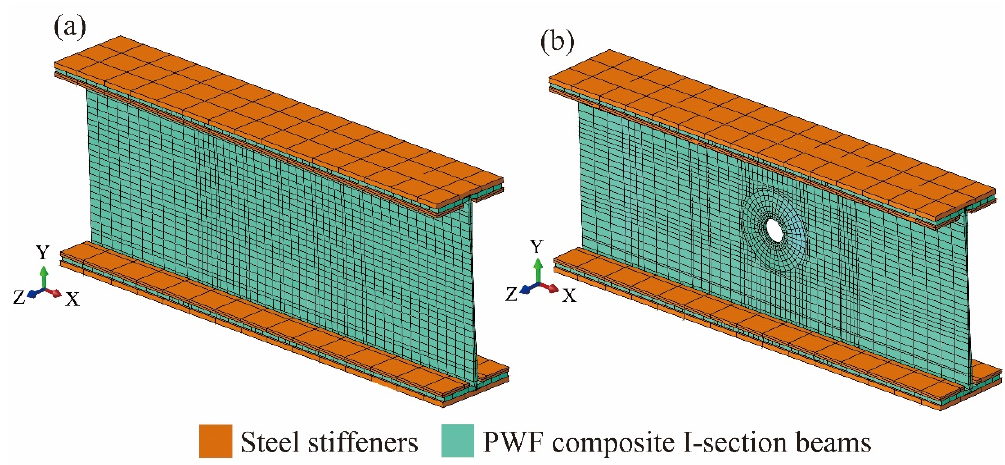
Figure 14. The macro-scale FE models of the T300/Epoxy PWF composite I-section beams: ( a ) specimens of BW-I; ( b ) specimens of BW-II.